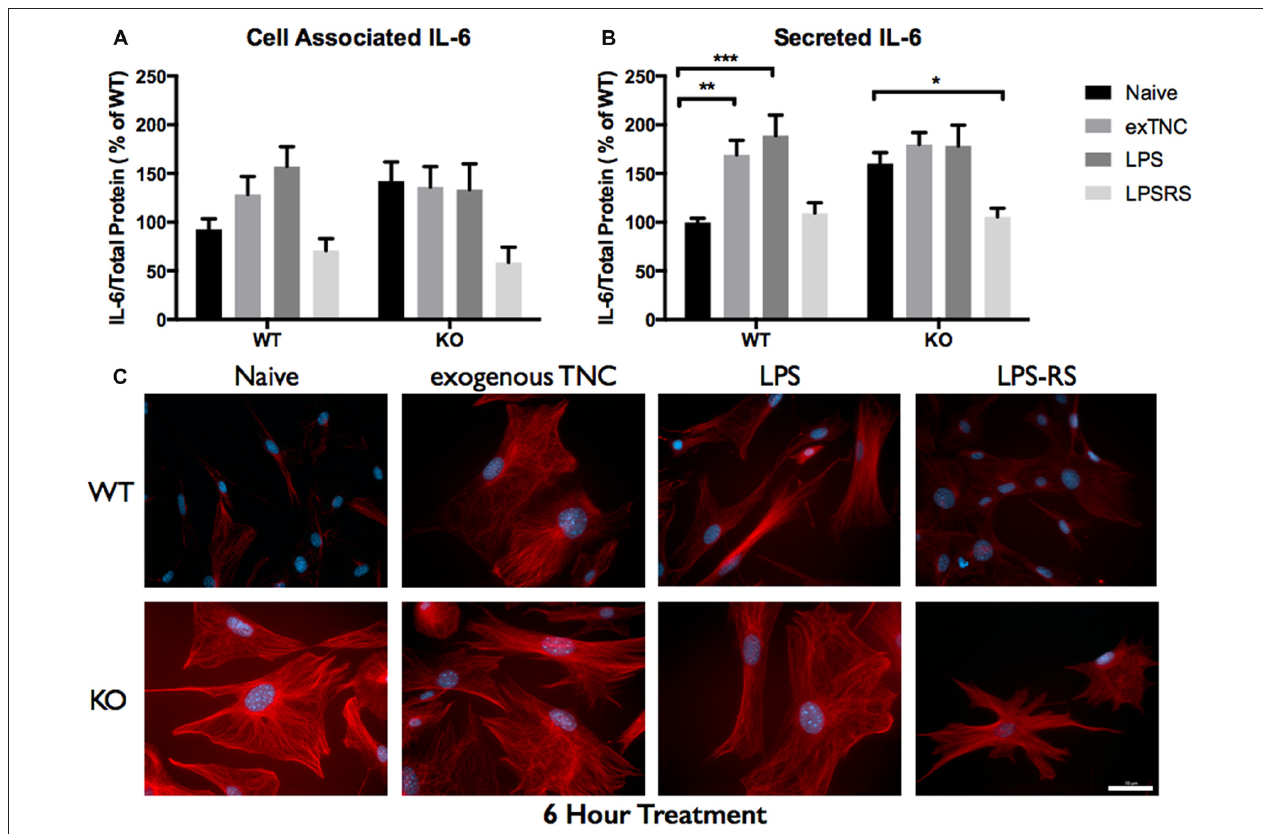
FIGURE 6 | Secreted IL-6 expression post a 6-h treatment is significantly altered following TLR4 activation. (A) Cell associated astrocyte expression of IL-6 in WT ( n = 6/group) and FMR1 KO ( n = 6/group) astrocyte cell cultures grown for 7 days in vitro . The culture was treated with LPS (10 µ g/mL), exogenous TNC (10 µ g/mL) and LPS-RS (10 µ g/mL) for 6 h prior to collection. Representative bands were normalized to the total protein and expressed as a percentage of the average IL-6 in the WT group. (B) Extracellular astrocyte expression of secreted IL-6 in WT ( n = 6/group) and FMR1 KO ( n = 6/group) astrocyte cell cultures grown for 7 days in vitro . The culture was treated with LPS (10 µ g/mL), exogenous TNC (10 µ g/mL) and LPS-RS (10 µ g/mL) for 6 h prior to ACM concentration and collection. Representative bands were normalized to the total protein and expressed as a percentage of the average IL-6 in the WT group. Statistical differences denoted with a single asterisk, P < 0.05, a double asterisk, P < 0.01 and with triple asterisk, P < 0.001. (C) Cultured cortical astrocytes co-labeled with DAPI (blue) and anti-IL-6 (red) after 3 days in vitro , following a 6 h treatment. Images were obtained using a 40 × objective with a Zeiss Axioimager M2. Scale bars = 50 µ